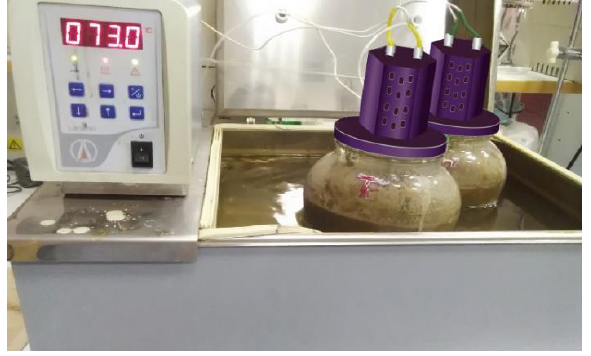
Figure 1. Hand-made mash tun in a water bath during the mashing process.